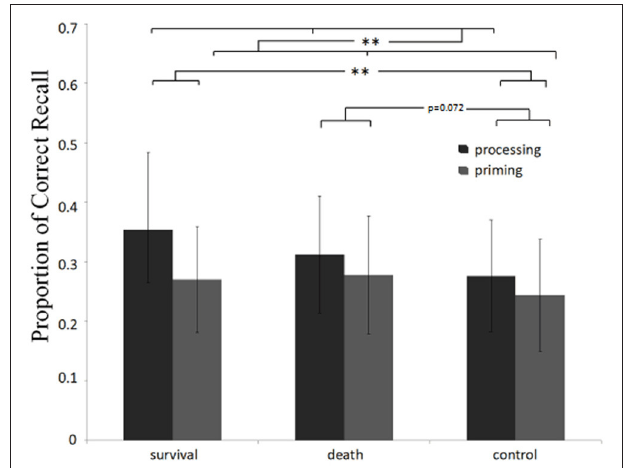
FIGURE 1 | Average proportion of correct recall sorted by conditions in Experiment 1. Error bars indicate standard deviations in each group. ** p < 0.01.